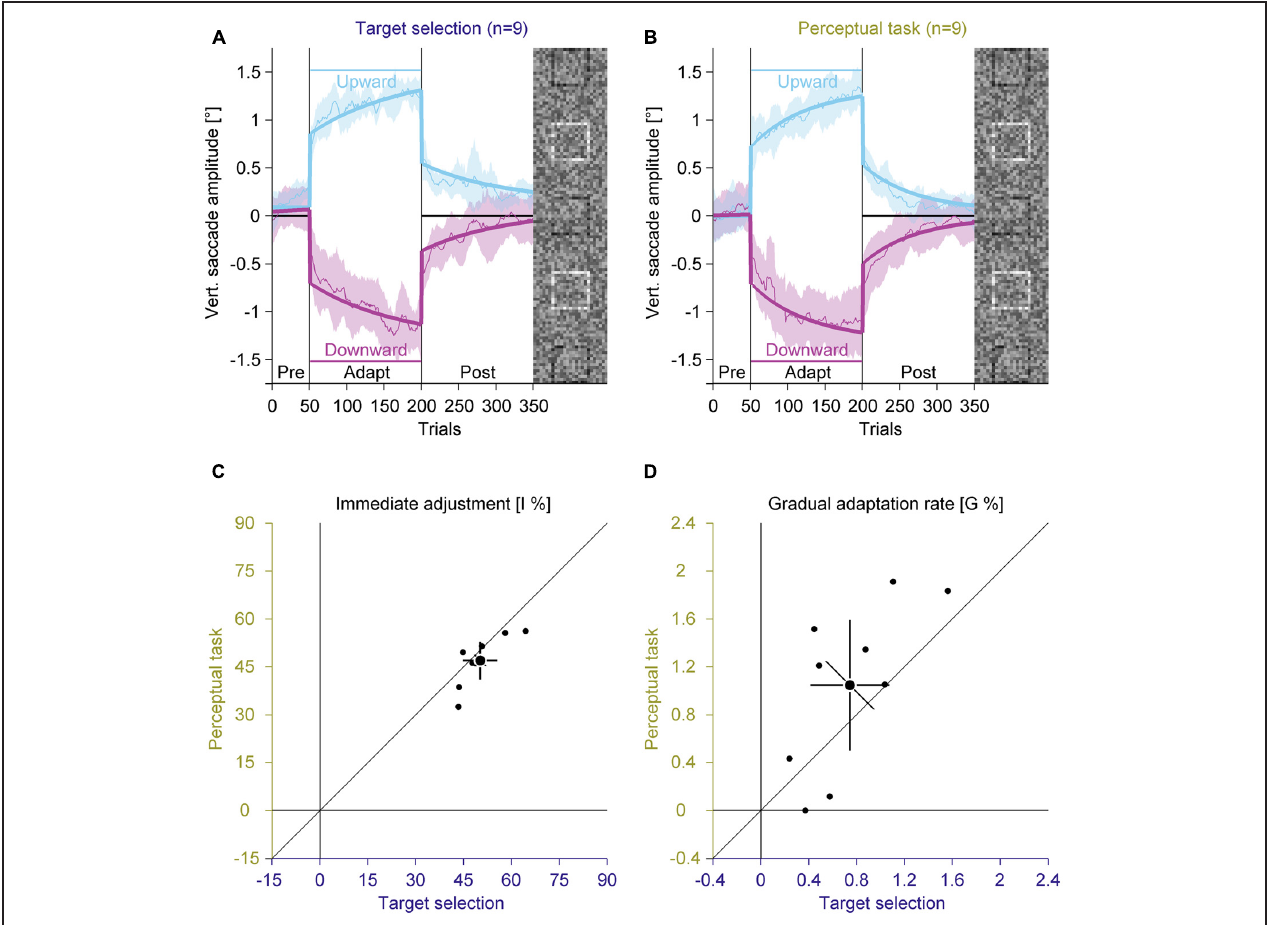
FIGURE 6 | Experiment 3, saccadic adaptation with instruction for target selection and with perceptual task. (A) Saccadic adaptation with instruction for target selection. (B) Saccadic adaptation with perceptual task. (C) Immediate adjustment in the two-state model fits. (D) Gradual adaptation rate in the two-state model fits. (A–D) Conventions are the same as in Figure 3